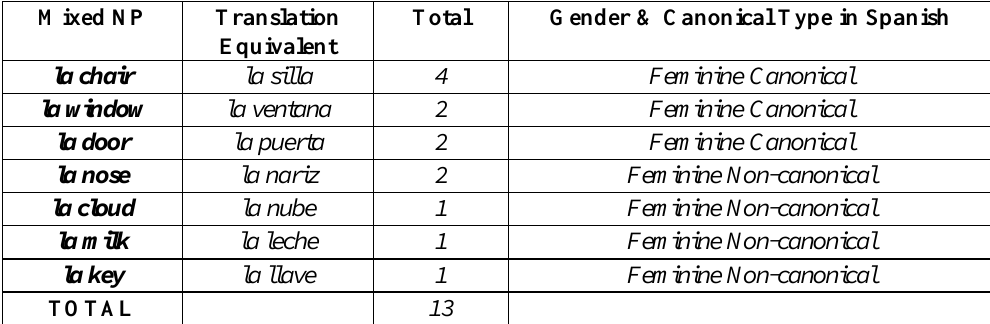
Table 7. Mixed NPs containing nouns a feminine determiner and an English noun with a Spanish feminine translation equivalent